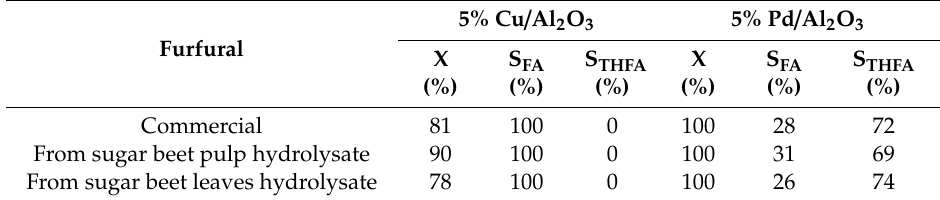
5% Cu / Al 2 O 3 5% Pd / Al 2 O 3 X S FA S THFA X S FA S THFA (%) (%) (%) (%) (%) (%)